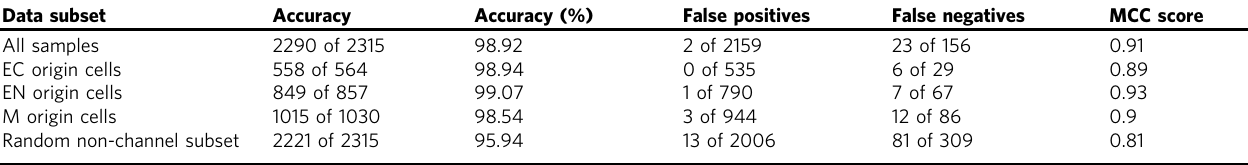
Table 1 Results from binary classi fi cation analysis of 11,574 samples from the TCGA